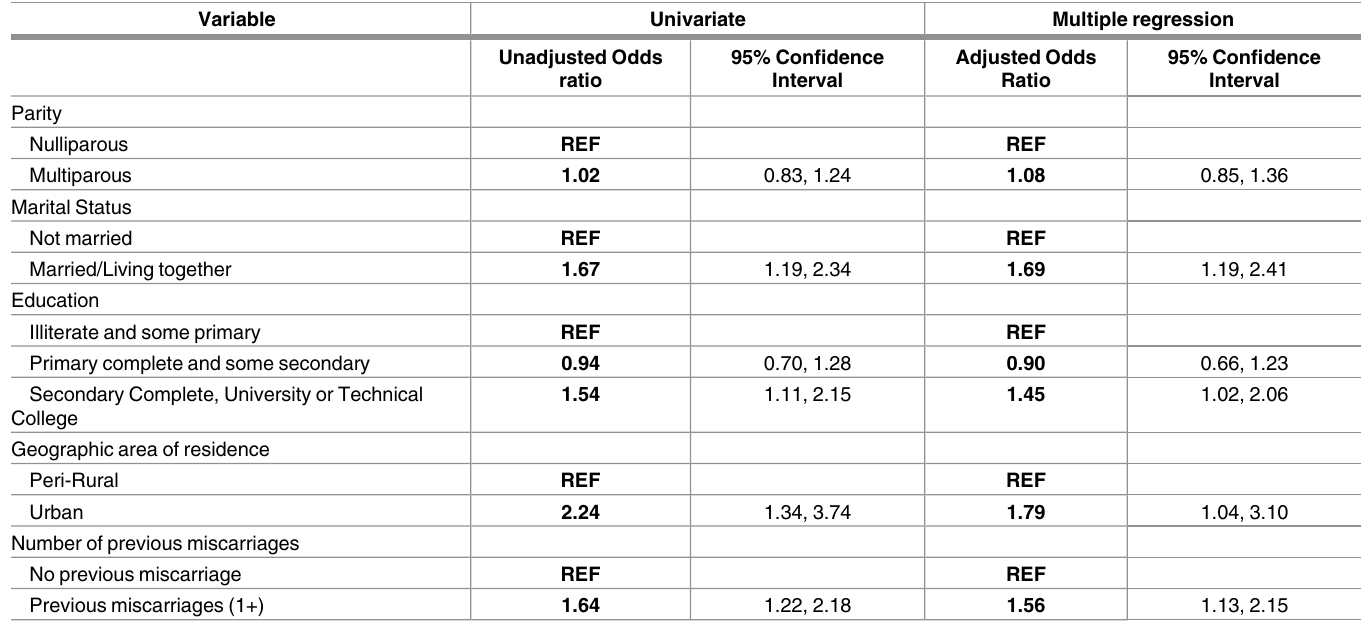
Table 2. Unadjusted and Adjusted Odds ratios 1 for determinants of early first ANC attendance in the Bele´n community of Iquitos, Peru, 2010– 2012.